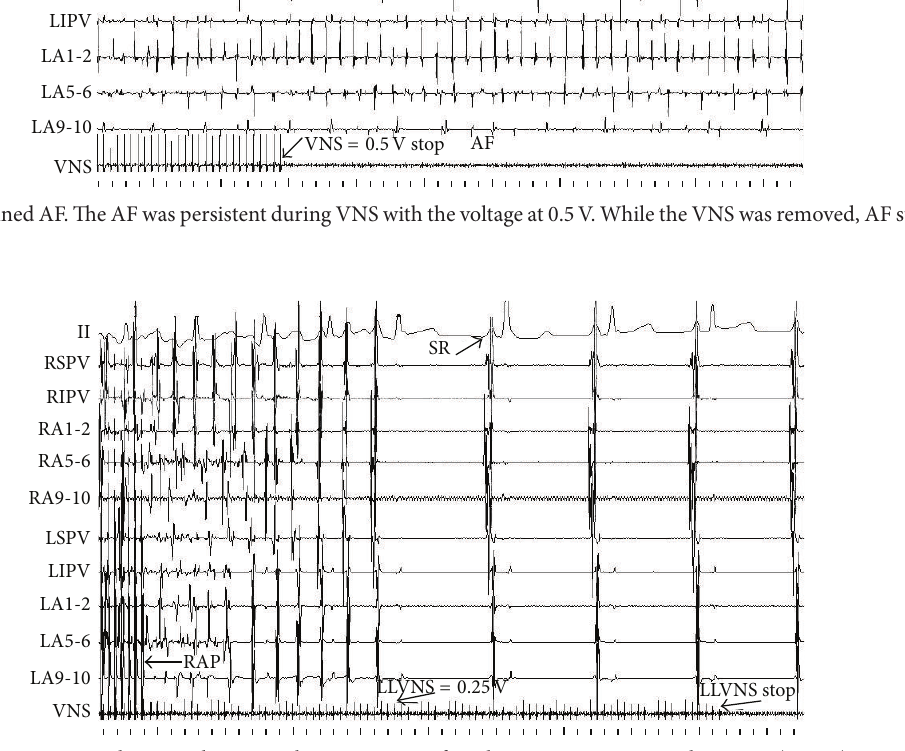
Figure 9: LLVNS cannot maintain the AF. When RAP that is persistent for 3 hours concomitant with LLVNS (0.25 V), was stopped, the AF progressively terminated even though the LLVNS still continued. RAP: rapid atrial pacing. SR: sinus